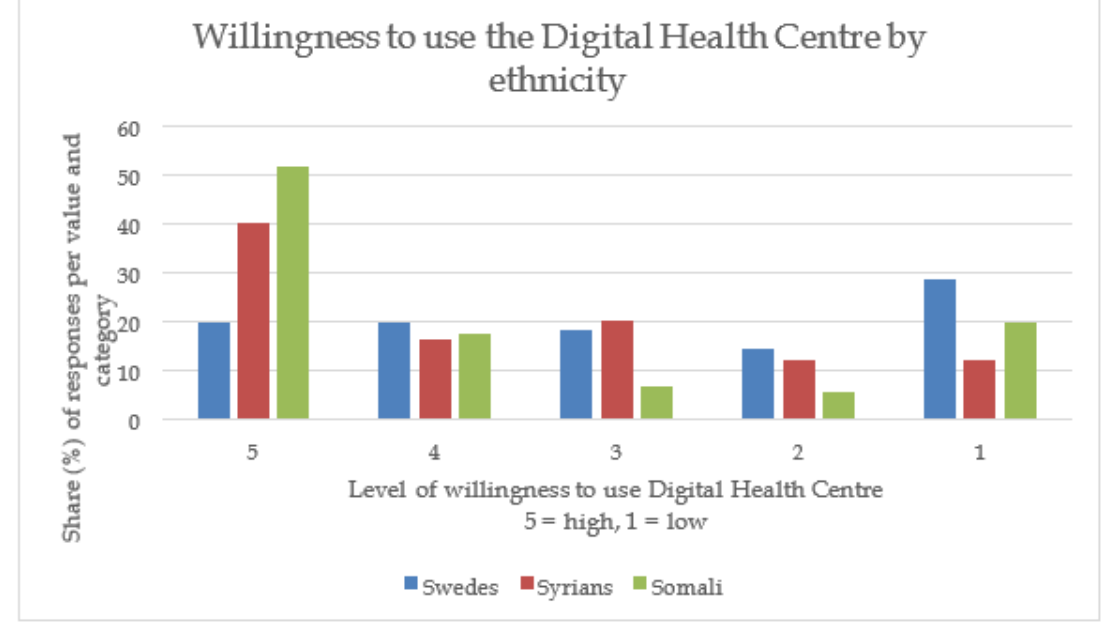
Figure 12. Willingness to use the Digital Health Centre and ethnicity. Percentage per reported value on scale 5-1. Swedes n=56 (100%); Syrians n=25 (100%); Somalis n=93 (100%). Total n=174.